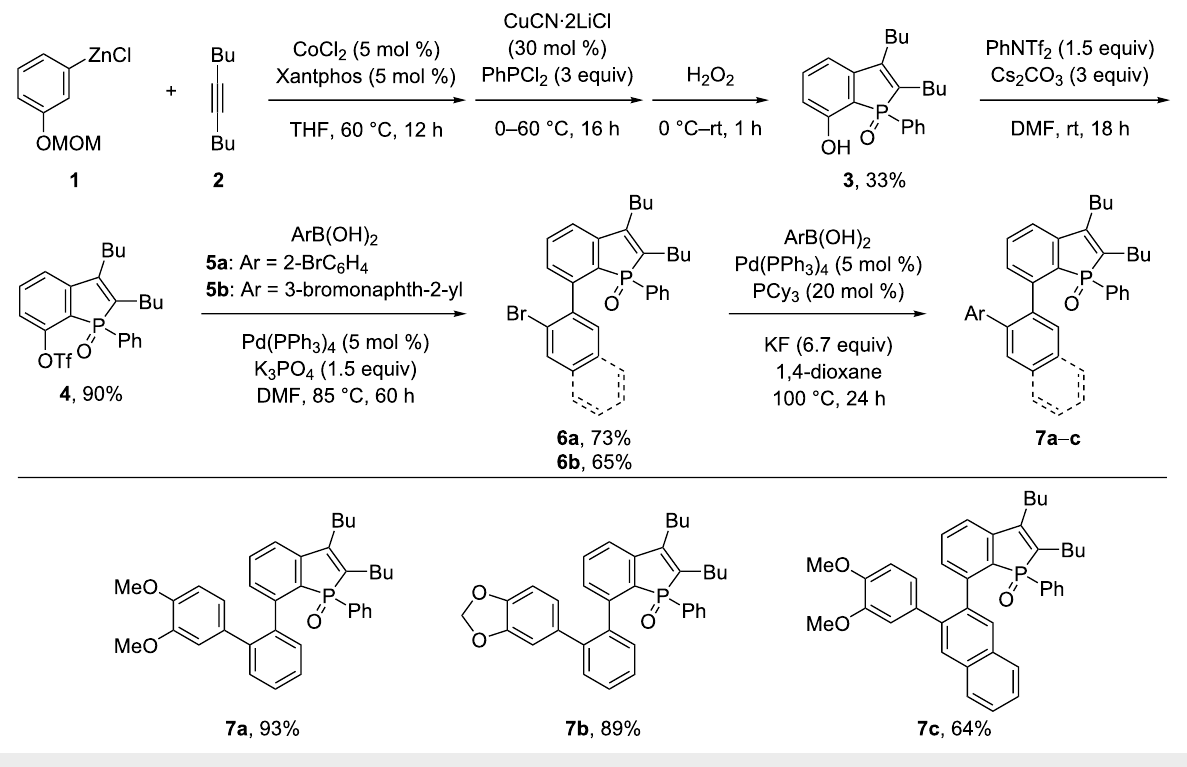
Scheme 2: Synthesis of phosphole-fused ortho -teraryl compounds 7